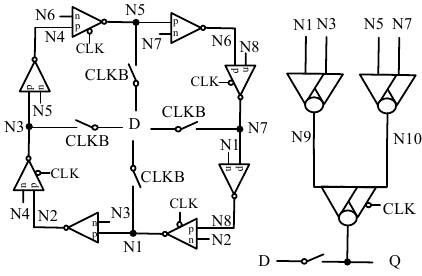
Figure 2. Latch schematic for LCTNUT.